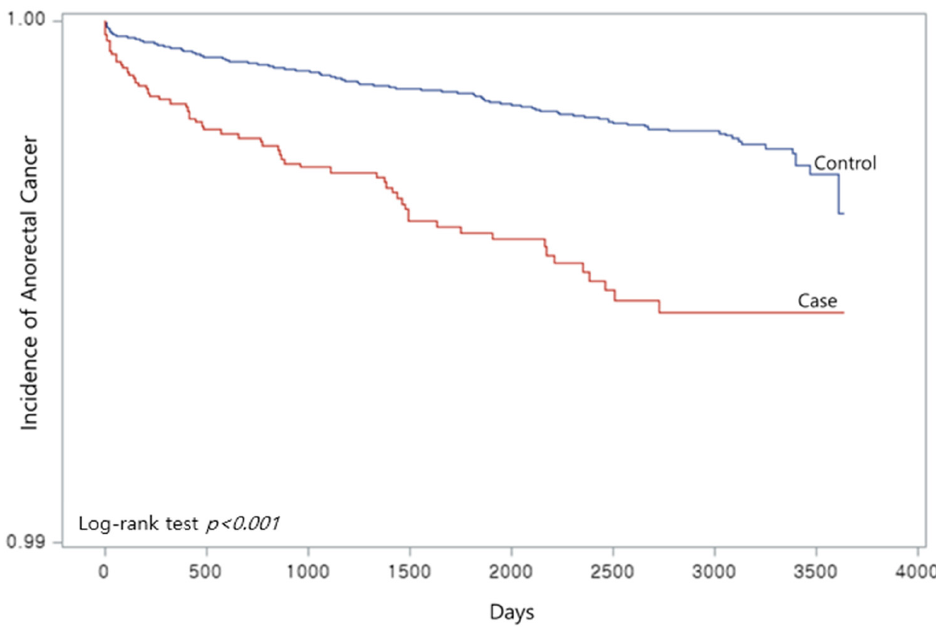
Figure 2. Kaplan-Meier curve on anal fissure and anorectal cancer.